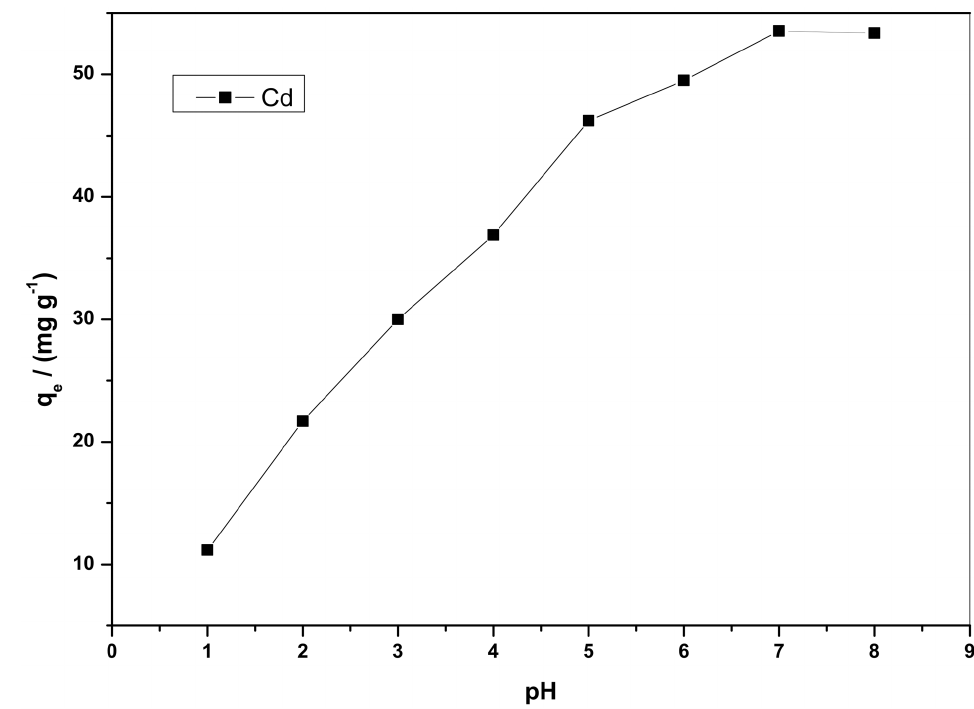
Figure 1. Effect of initial pH on the biosorption of Cd 2 + by Sargassumfusiforme . doi:10.1371/journal.pone.0095242.g001 PLOS ONE |